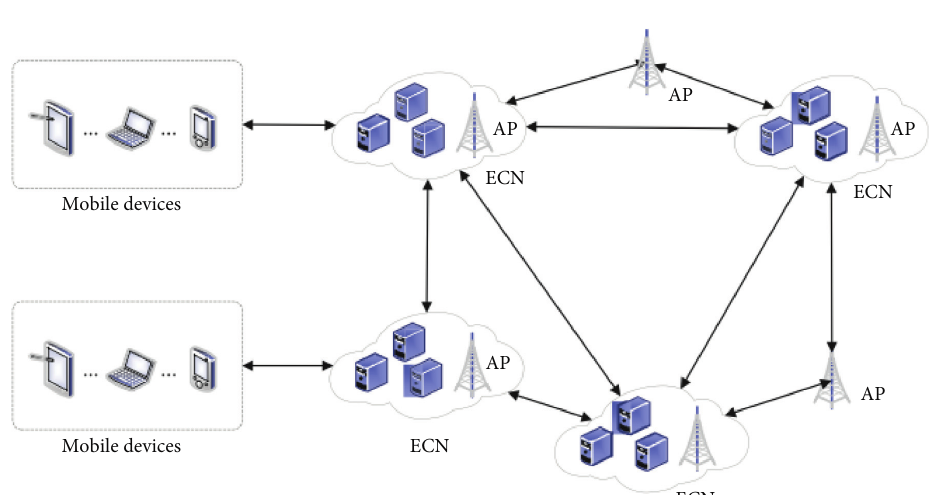
Figure 5: An architecture of smart edge computing [59].